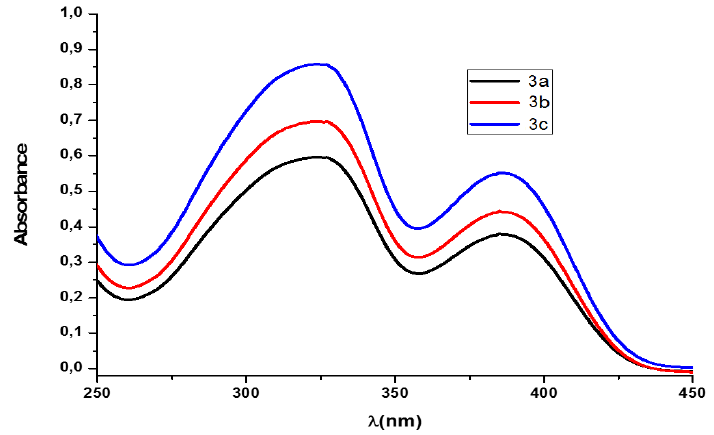
Figure 1. UV–Vis spectra of pyridinium tetrafluoroborates 3a–c in chloroform ( ca. 9 × 10 −4 M). Upon cyclization, the extended heterocyclic π−system exhibited several new bands around 360, 430, and 470 nm, in addition to the major absorption around 330 nm, which consisted of at least two resolved bands (Figure 2).